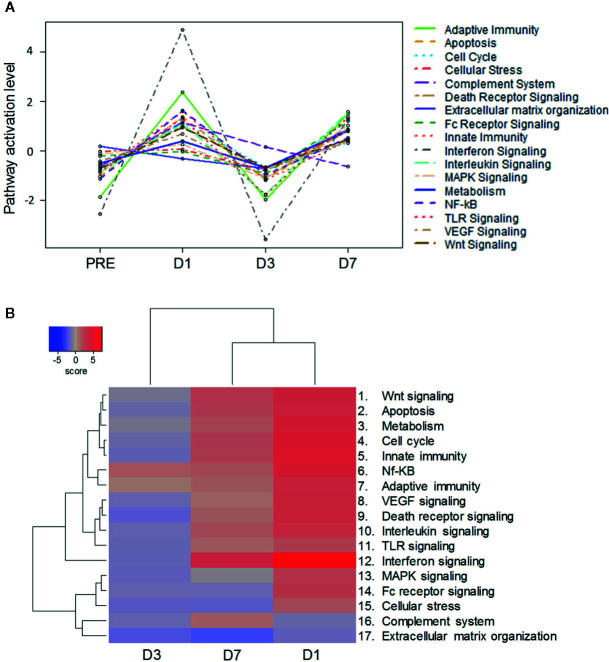
Bimodal kinetic pattern of gene signatures in ChAd155-RG-immunized macaques. Whole blood was collected at pre-vaccination (“PRE”) and 1, 3 and 7 days post vaccination (D1, D3, D7) from six macaques injected intramuscularly with ChAd155-RG rabies vaccine (5 × 1010 vp) at Day 0. Modulation of gene expression across timepoints was analyzed through pathway scoring (A) and gene set analysis (B), with both methods leading to analysis of pathway modulation at the different timepoints. Significantly enriched immune-related pathways are listed at the right side of each panel (see
Table S2
 for gene lists per pathway). (A) For pathway scoring, principal component (PC) analysis was performed for each sample using a linear combination (weighted average) of its gene expression values, weighing specific genes to capture the greatest possible variability in the data. The first PC reflects any factor(s) emerging as main driver(s) of variability in gene expression of that particular gene set. (B) Gene expression values were expressed as log2 fold-changes over baseline (P-value < 0.05). Differential expression and pathway enrichment analyses were performed by direct global significance analyses using NanoString nSolver 4.0 with Advanced Analysis 2.0 plugin (730-gene panel).